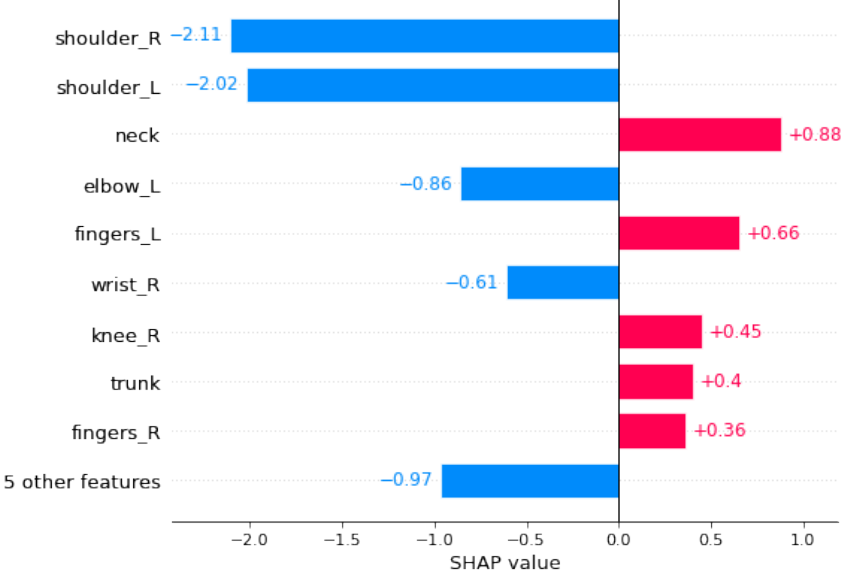
Figure 8. Bar plot for 5 sample records. On the y-axis, the most influential factors are arranged from top to bottom based on their contributions to the model output. The x-axis indicates their changing amount to the SHAP